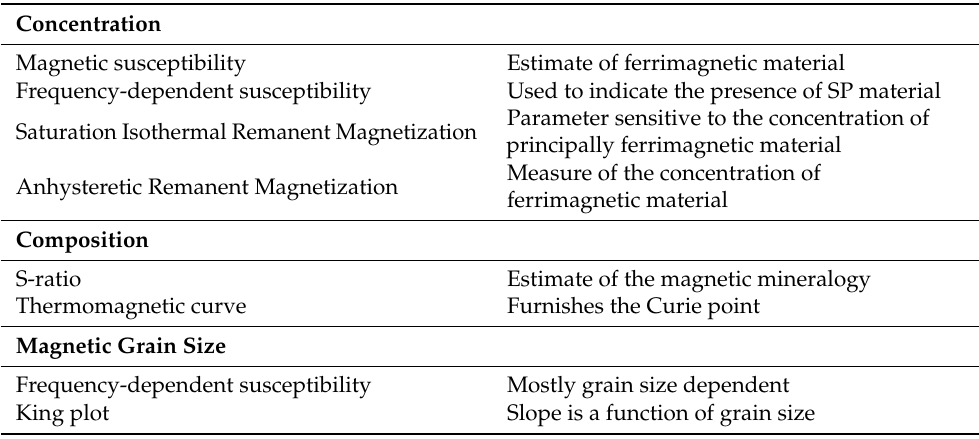
Table 2. Parameters and specific plot with their interpretations used in our study (information taken by [1]).